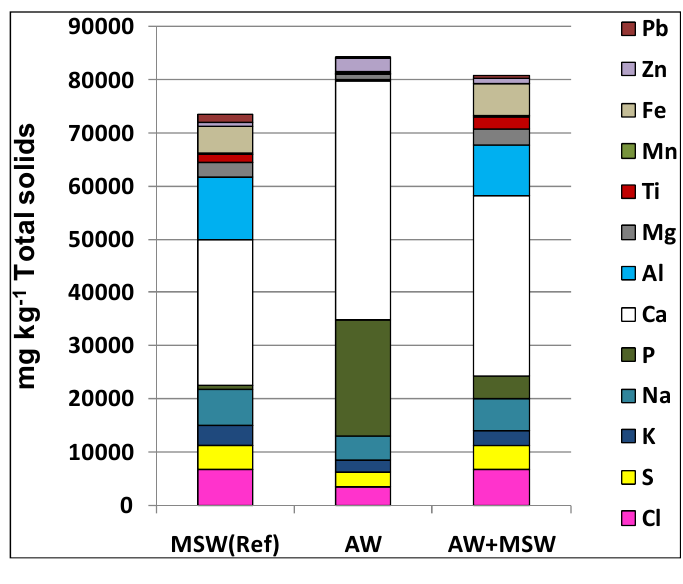
Figure 3. Composition of fuels and fuel mix.